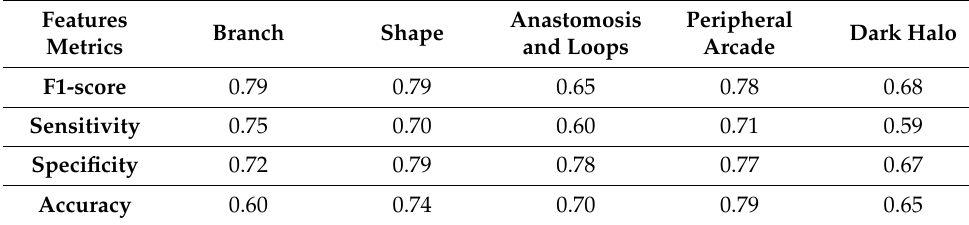
Table 4. Classification metrics for five classifiers without the use of the SEG-PA and SEG-DH